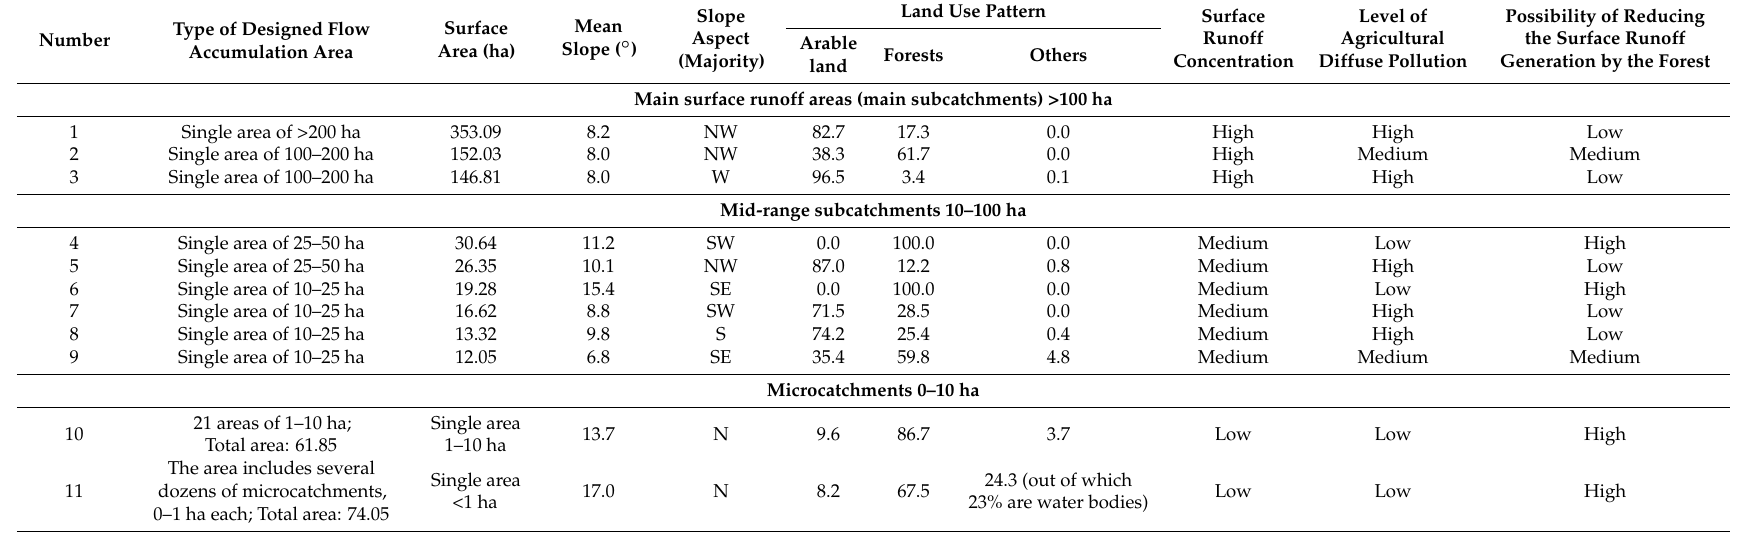
Table 4. Basic characteristics of designed flow accumulation areas (numbers according to Figure